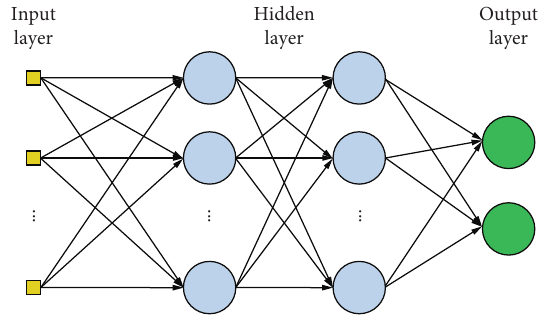
Figure 10: MLP neural network model.